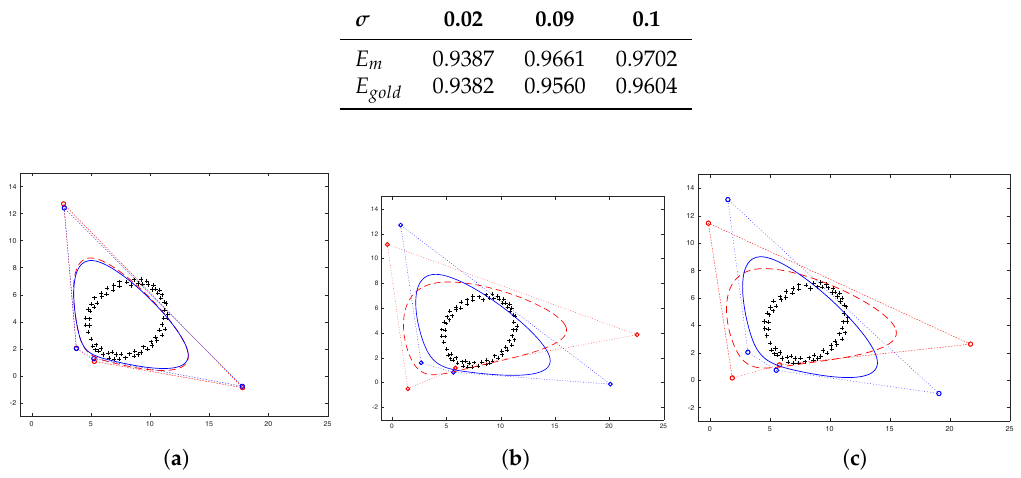
Table 5. Computation of approximation error E m and E gold using different values of σ .